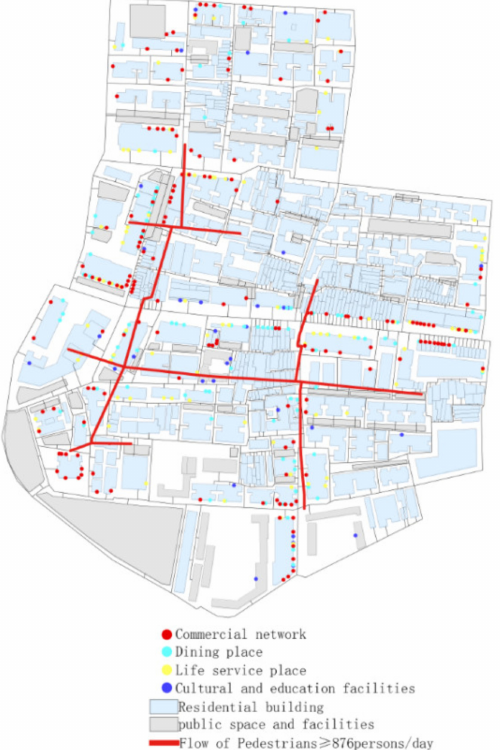
Figure 9. Distribution map of crowded routes from residential buildings to commercial facilities.